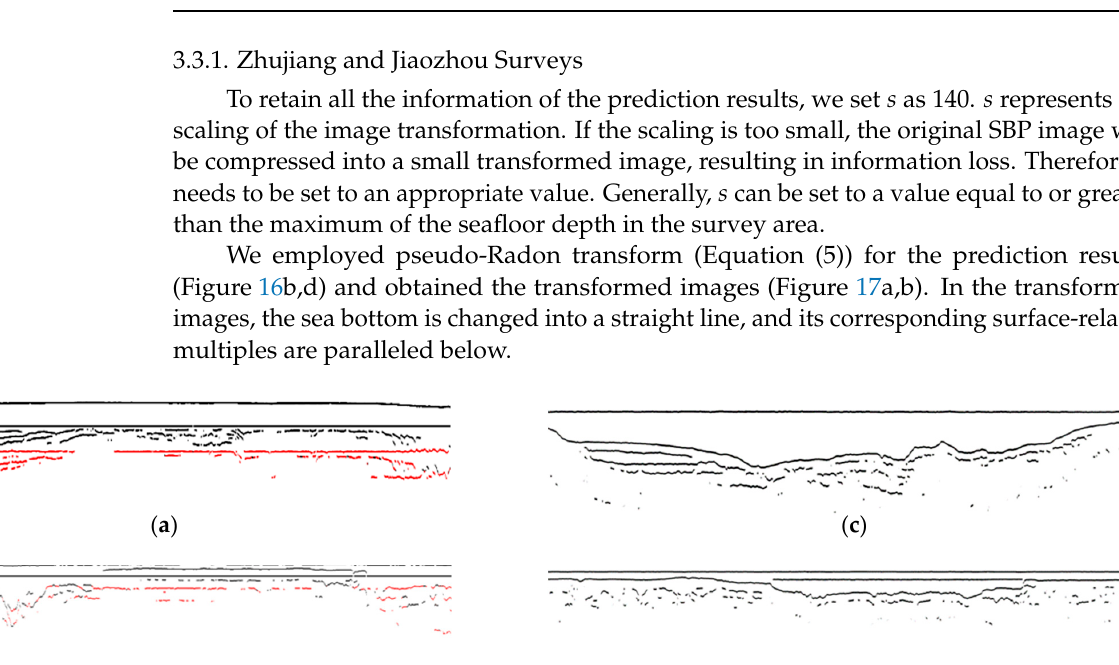
Figure 18. Comparison of multiple suppression results. ( a , c , e ) represent SBL_20120628_085229. ( b , d , f ) represent SBL_20160305_025613. ( a , b ) are the results of the proposed multiple suppression method. ( c ~ f ) are the results of predictive deconvolution. The predictive step of ( c , f ) is 25, and the step of ( e , f ) equals instantaneous seawater depth.